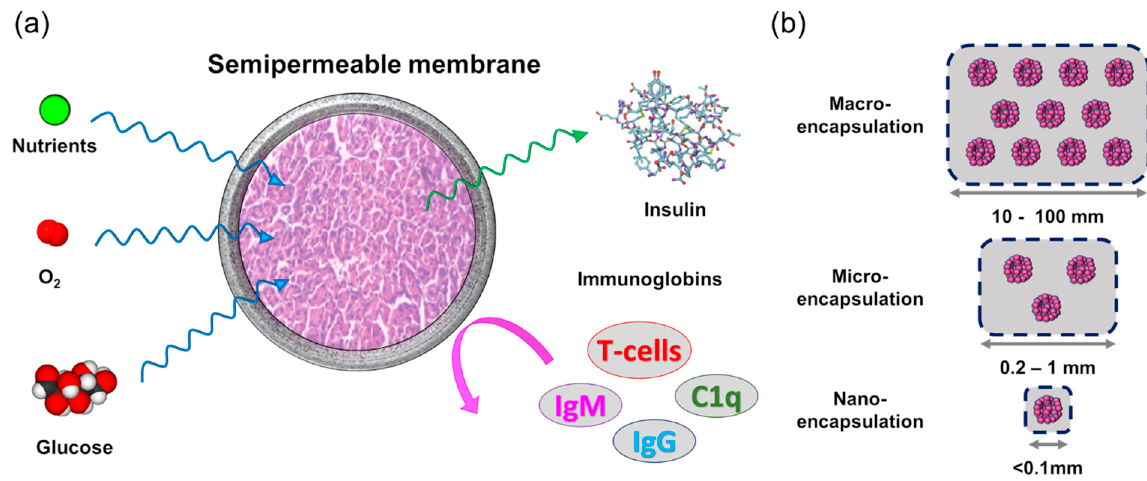
Figure 16. (a ) Semipermeable membrane for bioartificial pancreas; ( b ) classification and dimension for each type of islet encapsulation devices.